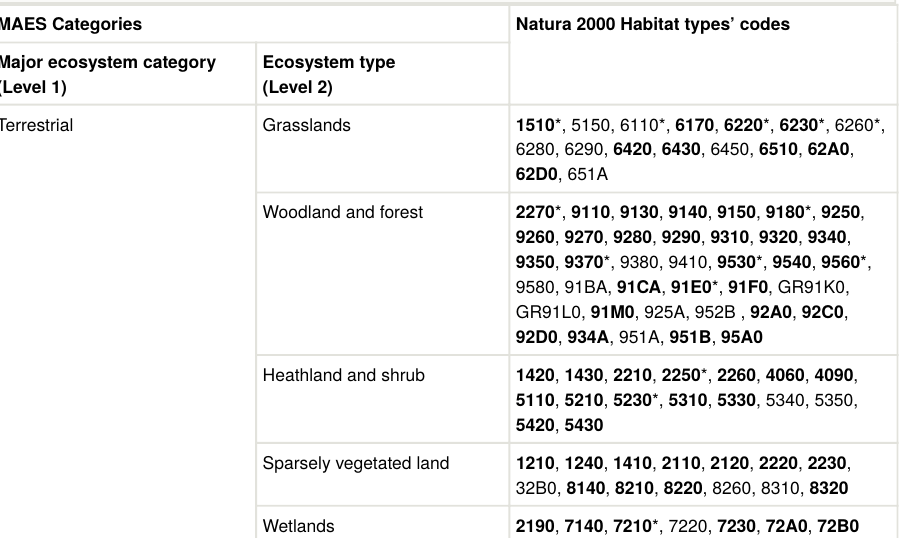
Typology of ecosystems and correspondence of the habitat types of Greece (Dimopoulos et al. 2018) with the MAES ecosystem categories and types (Level 1 and Level 2). Habitat type codes of Greek interest are underlined; in bold, the habitat types assessed in the present study; asterisk (*) indicates habitat types of conservation priority in Europe. The habitat type code names are provided in Suppl. material